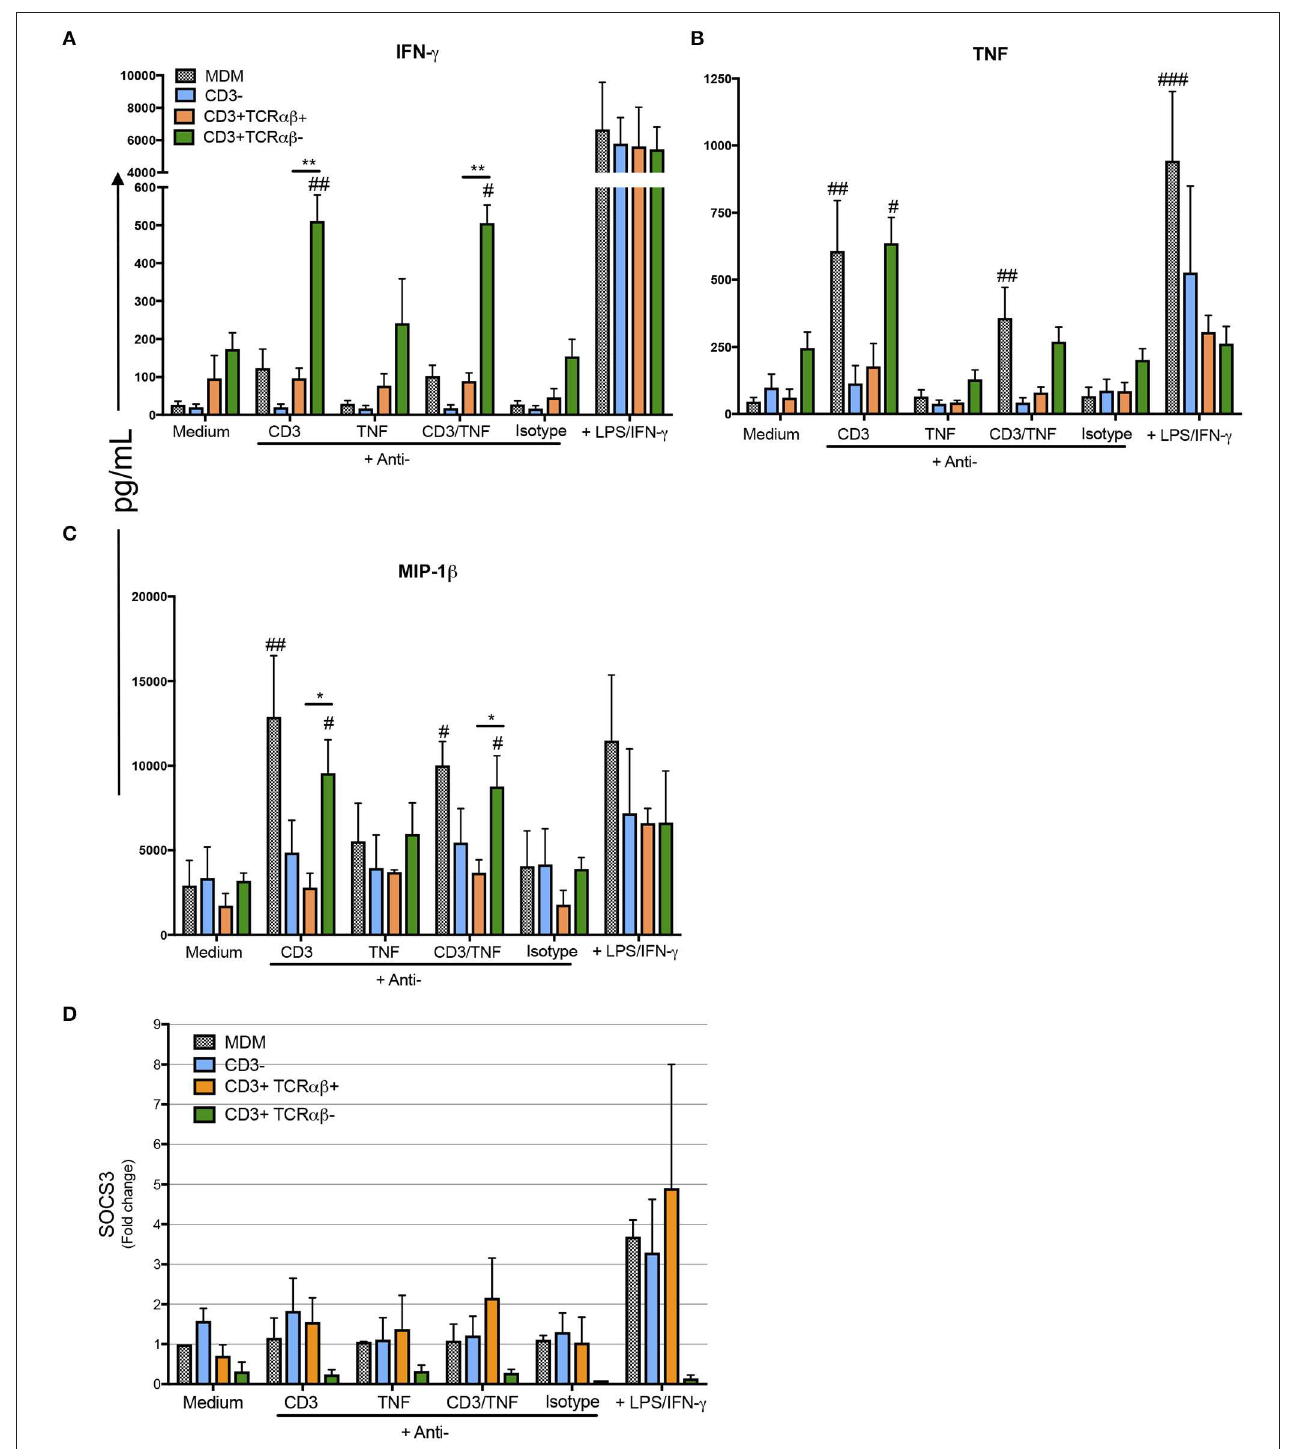
FIGURE 8 | CD3 + TCR αβ − MDM secrete IFN- γ , TNF, and MIP-1b by CD3- and TNF-dependent pathways. The supernatant of MDM subpopulations was recovered after 24h in culture from unstimulated or stimulated by anti-CD3 or anti-TNF antibodies or anti-CD3 plus anti-TNF, isotype control and LPS plus IFN- γ , to perform a multiplex analysis, while the cells were prepared to obtain mRNA. Pro-inflammatory cytokines IFN- γ and TNF ( A,B , respectively) and pro-inflammatory chemokine MIP-1 β (C) were evaluated using Luminex technology. The data are expressed as the mean ± SD of n = 4–6 independent donors per condition. A statistical analysis was performed with multiple Bonferroni-Dunn comparisons. * p < 0.05, # p < 0.05, ** p < 0.01, ## p < 0.01, and ### p < 0.001 (*Indicates the difference between groups, and # indicates the difference compared with its negative control condition). (D) The relative gene expression of SOCS3 was evaluated by real-time PCR. The bar graphs show the mean, and the data are representative of three independent